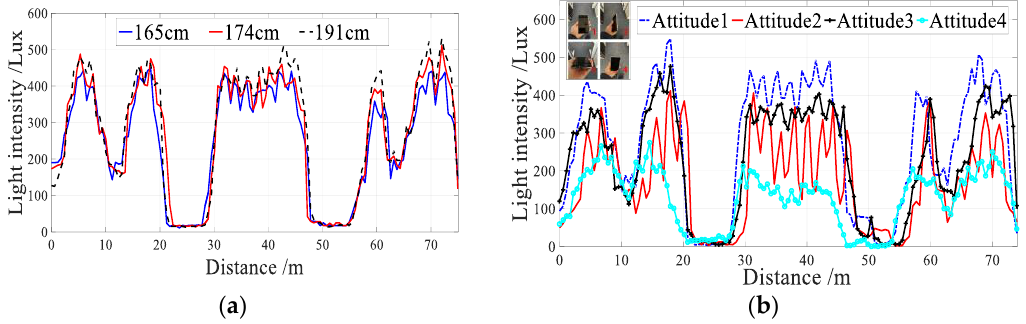
Figure 4. User Diversity. ( a ) Different heights; ( b ) Different attitudes.